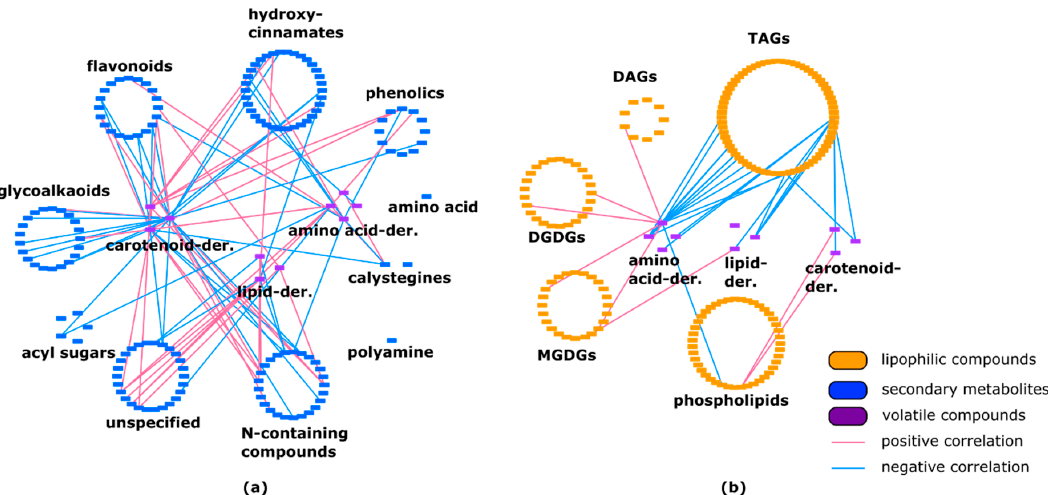
Figure 3. ( a ) Connection between secondary metabolites and volatiles in Solanum pennellii ILs. Volatile